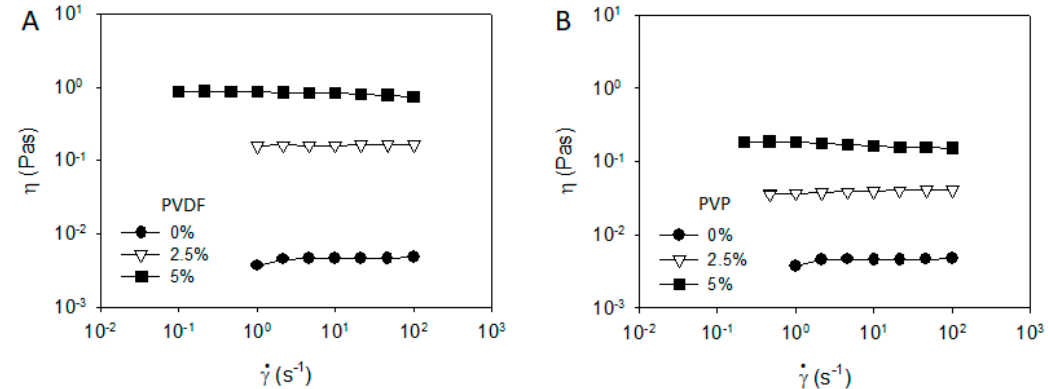
/ PVDF / NMP and ( B ) NCM / PVP /